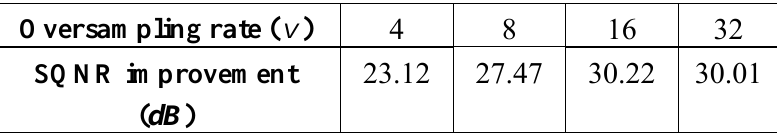
Table 1. SQNR improvement at different oversampling